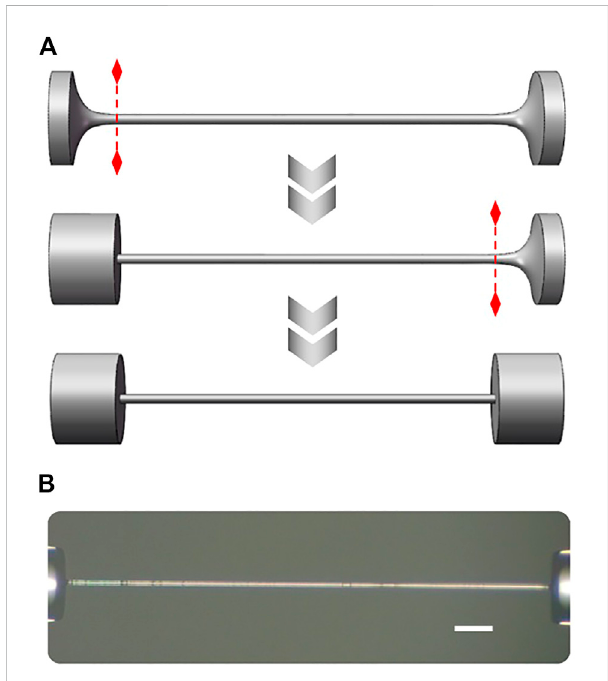
FIGURE 1 (A) Schematicofthefabricationprocessofthesensor. (B) Optical micrographofthesensor.Thewhitescalebaratthelowerrightcorner is 50 μ m.